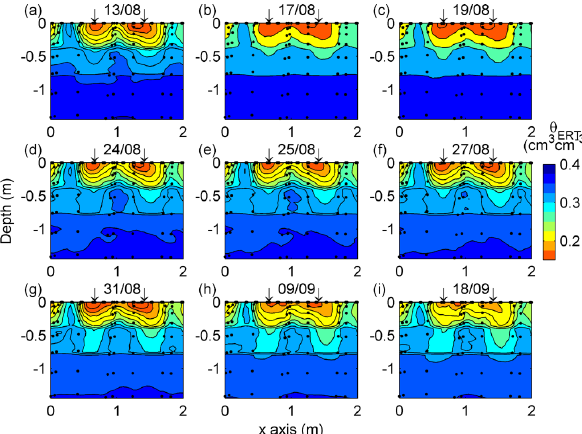
Fig. 12. Two-dimensional SWC distribution obtained by ERT on (a) 13 August 2009, (b) 17 August 2009, (c) 19 August 2009, (d) 24 August 2009, (e) 25 August 2009, (f) 27 August 2009, (g) 31 August 2009, (h) 9 September 2009, (i) 18 September 2009. The scale is the SWC (cm 3 cm − 3 ). The arrows indicate the maize row